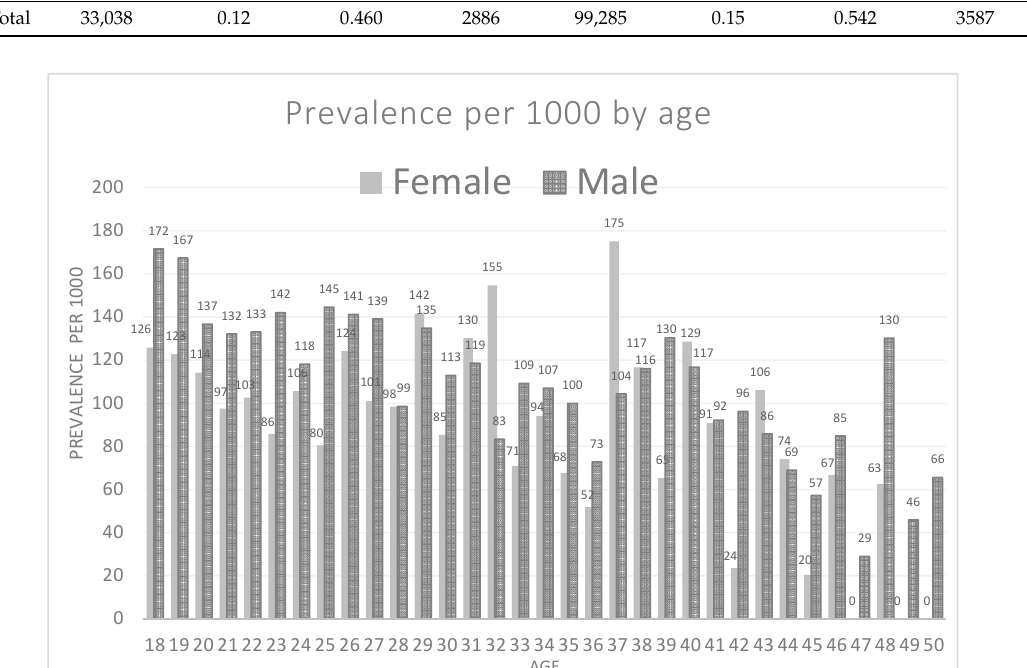
Figure 2. Rate of SOS teeth per 1000 by age among males and females.